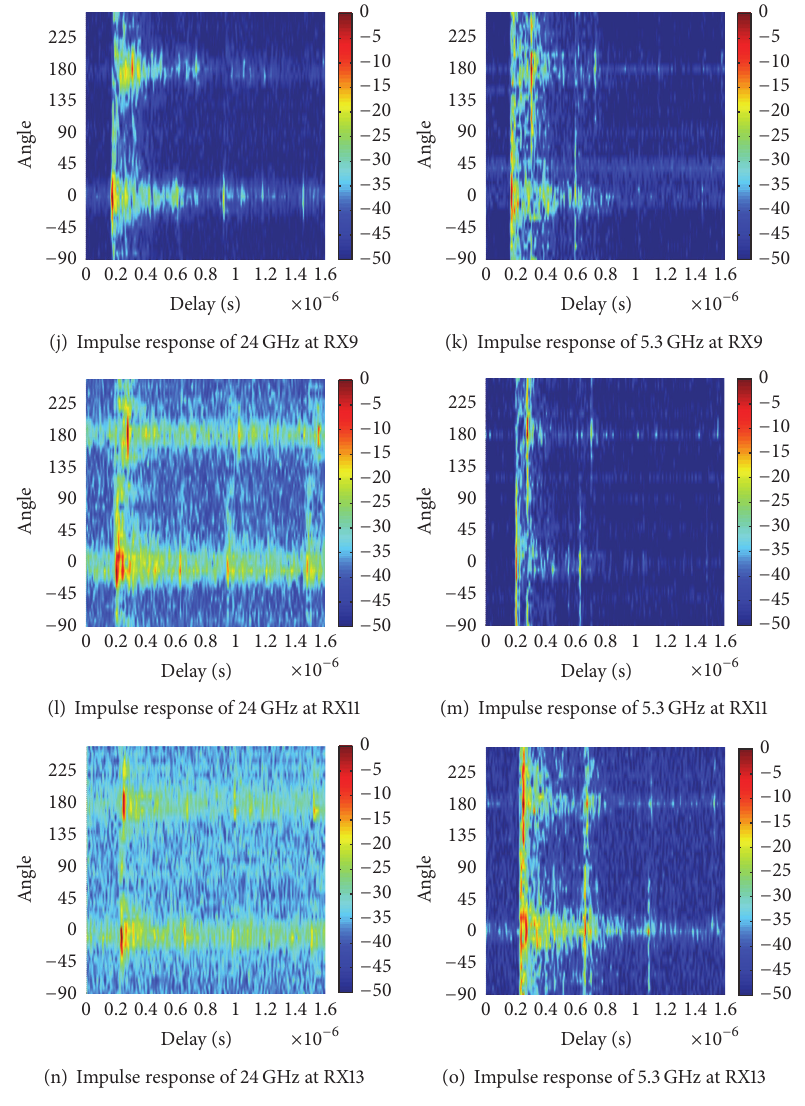
Figure 5: Measurement results of 24 GHz signals at 13 receiver